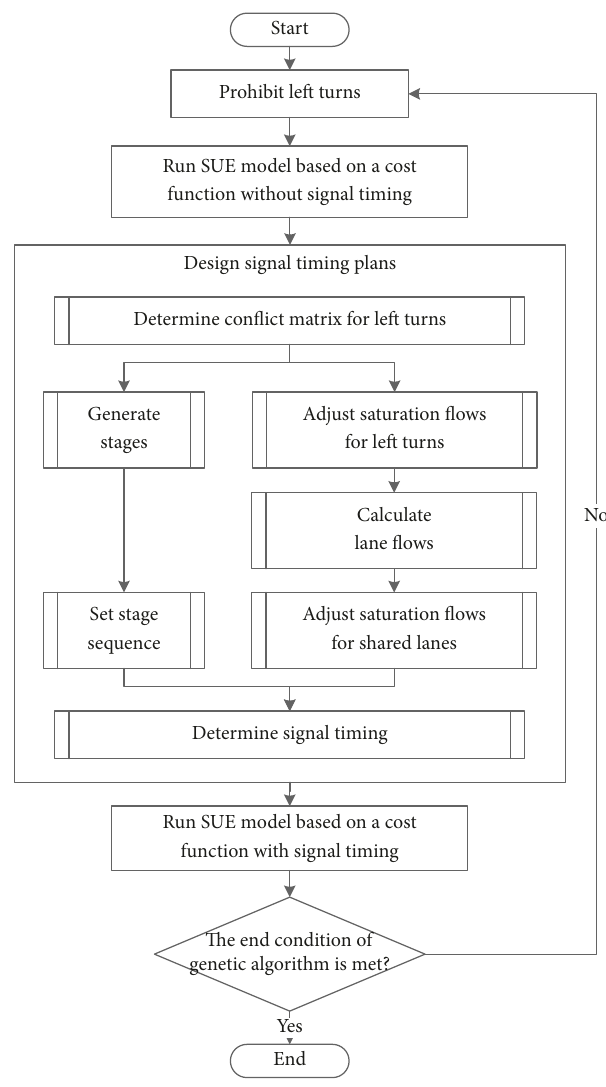
Figure 2: Flowchart of signal timing plan design including left turn